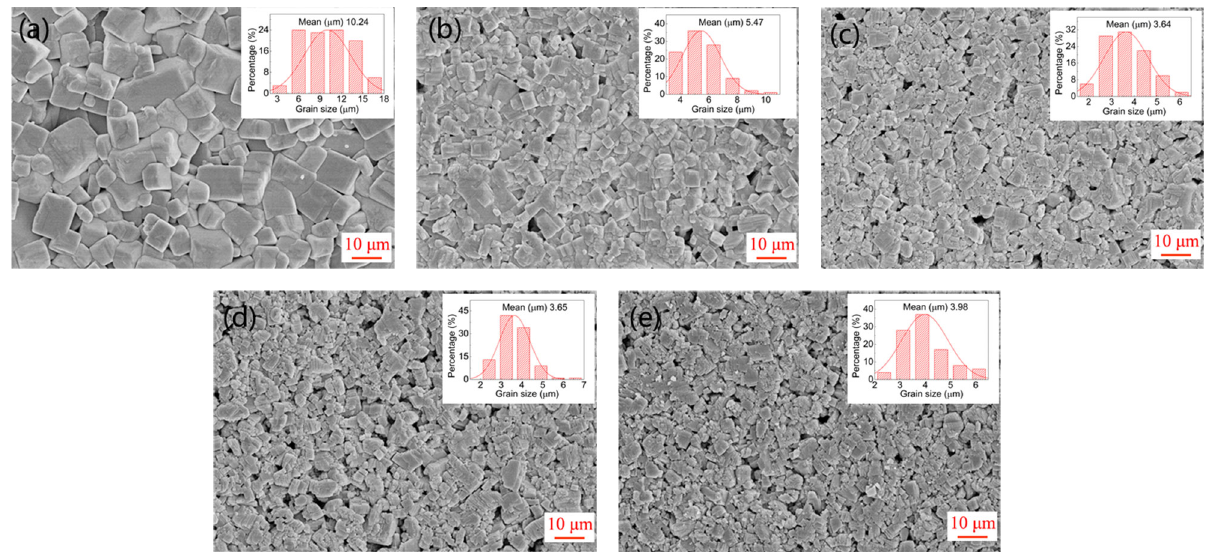
Fig. 3 SEM micrographs of (1 − x )KNN– x BZN ceramics: (a) x = 0.010, (b) x = 0.015, (c) x = 0.020, (d) x = 0.025, and (e) x = 0.030. The insets show the distribution of grain sizes.